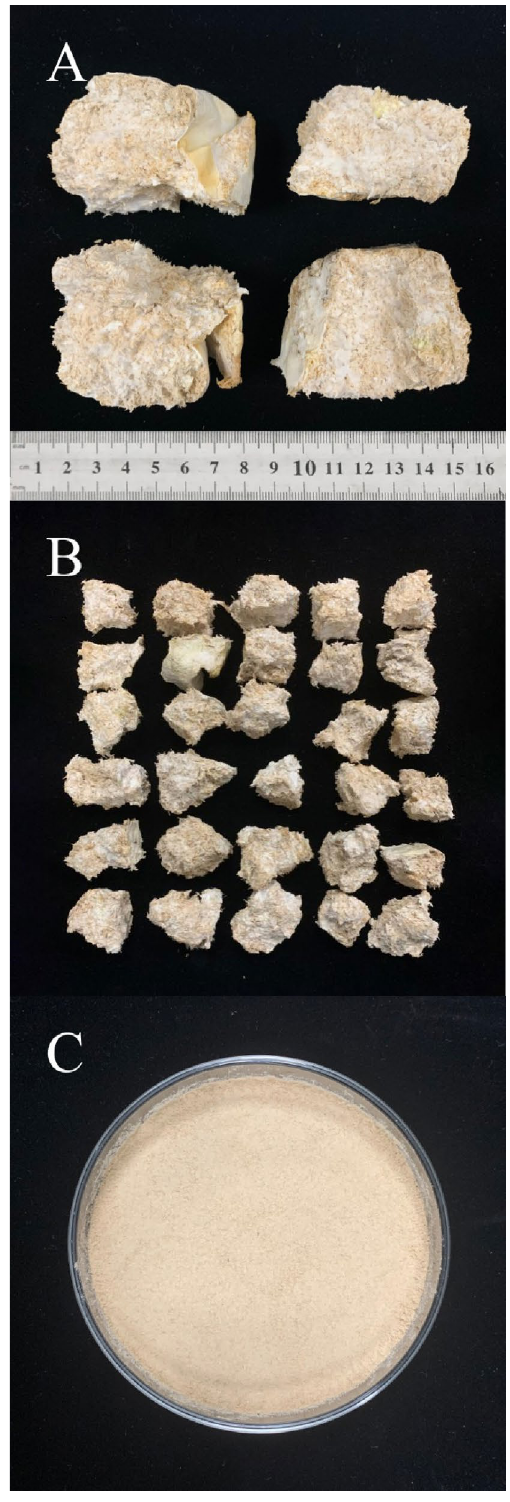
Figure 5. Photo of Poria cocos fermented Radix Astragali (( A ) the fermented Radix Astragali , ( B ) the small pieces of FRA, ( C ) the powder of